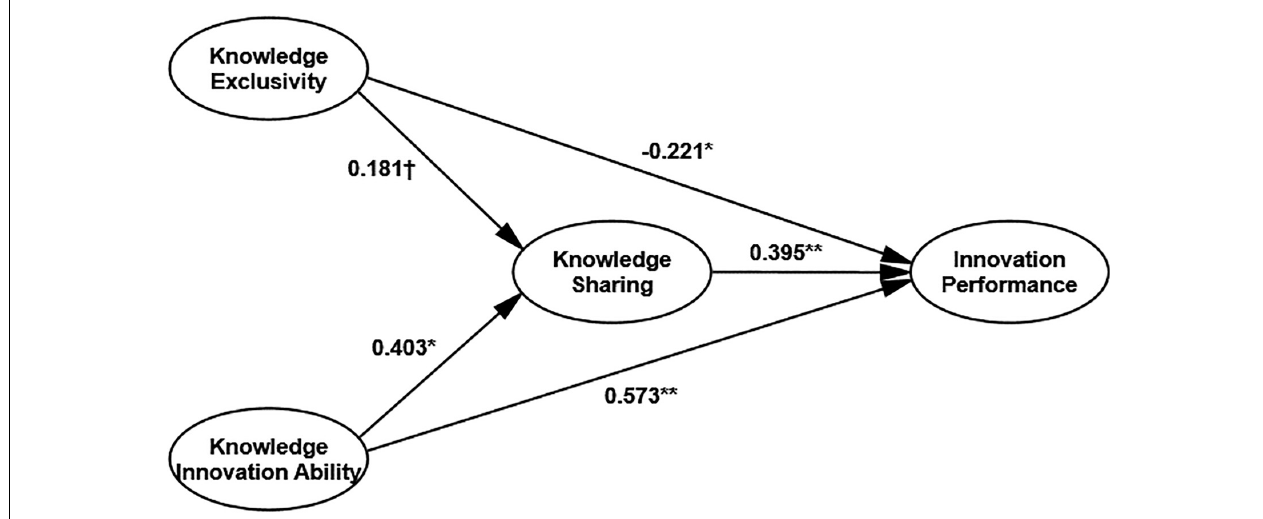
FIGURE 2 | Results of the mediating effect of knowledge sharing on the impact of member ability on innovation performance. ** p < 0.01, * p < 0.05, † p < 0.10.